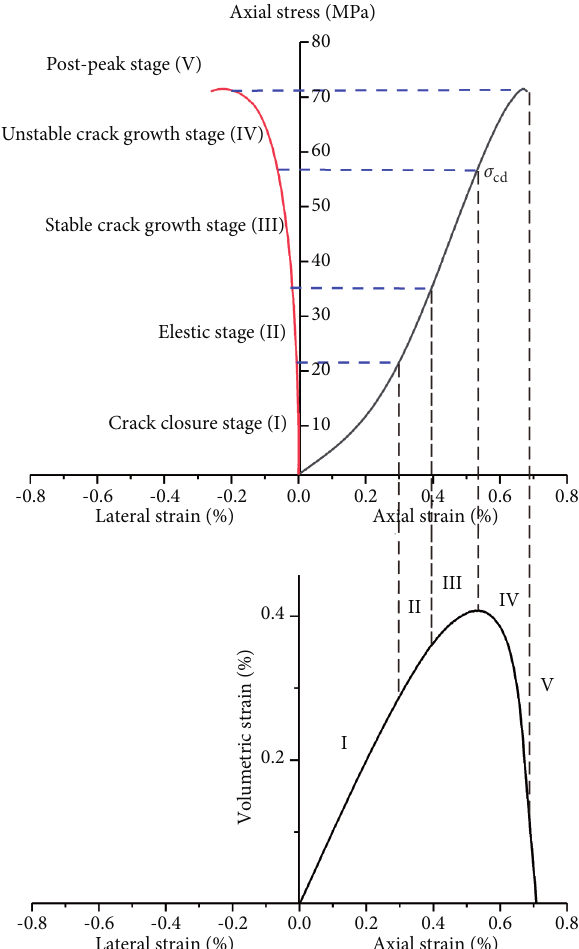
Figure 7: Stage division of rock failure process and schematic diagram of crack damage stress ( σ